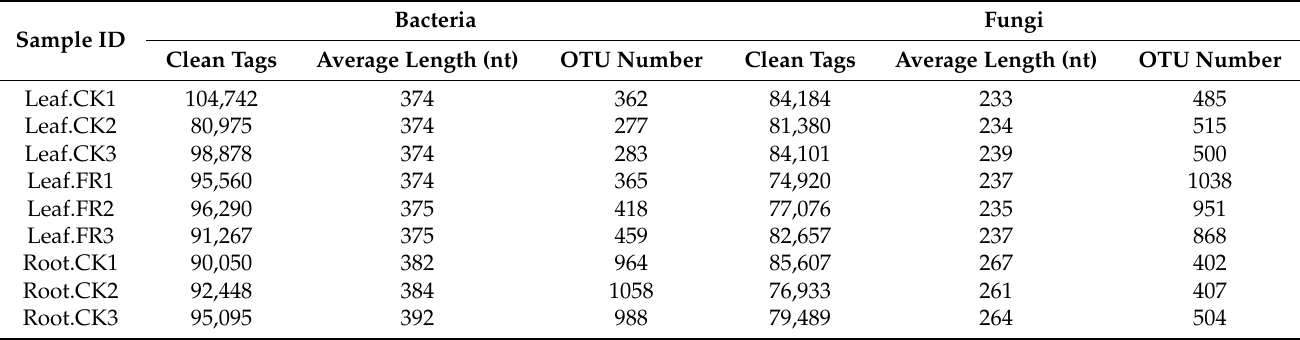
Table 1. Bacterial and fungal metabarcoding sequencing